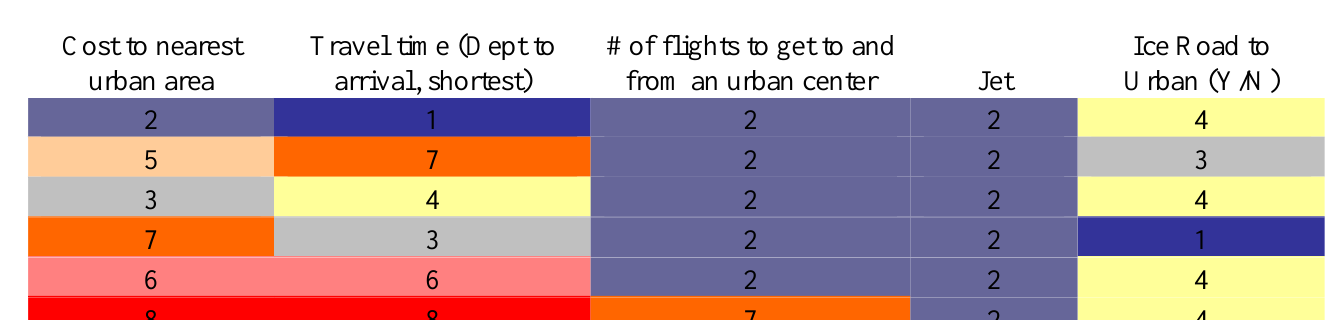
Table A2.2 Geography –